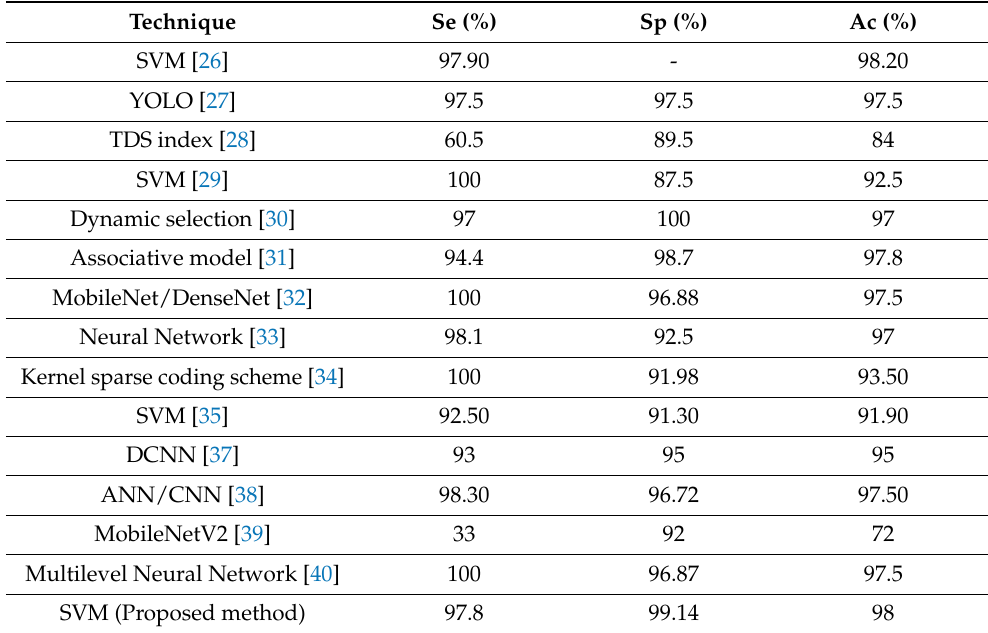
Table 1. Performance comparison among some most recent procedures indicated in literature that used the PH 2